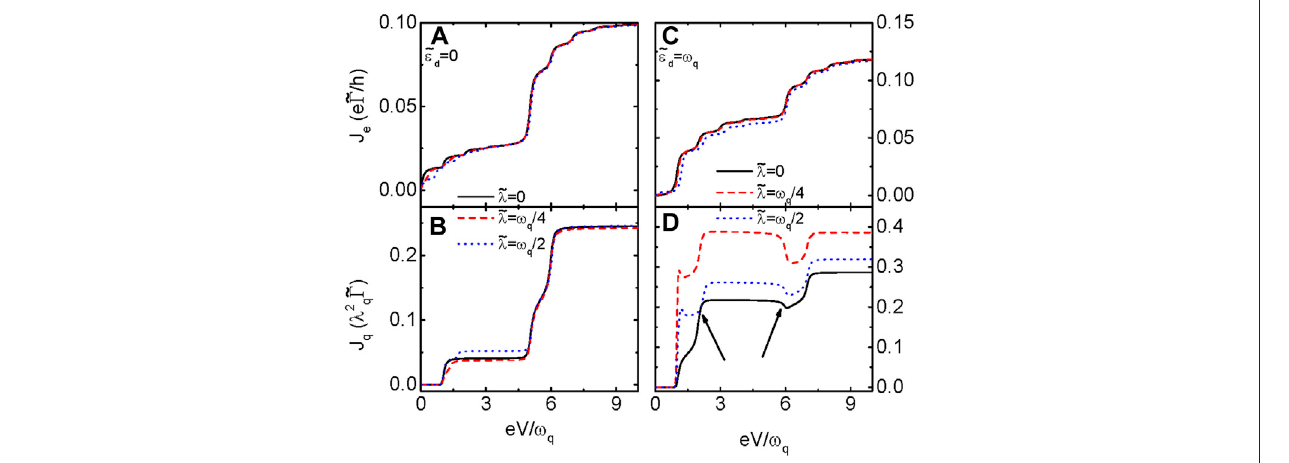
̃ λ is set at different values. Other parameters are λ q (cid:1) ω q ,